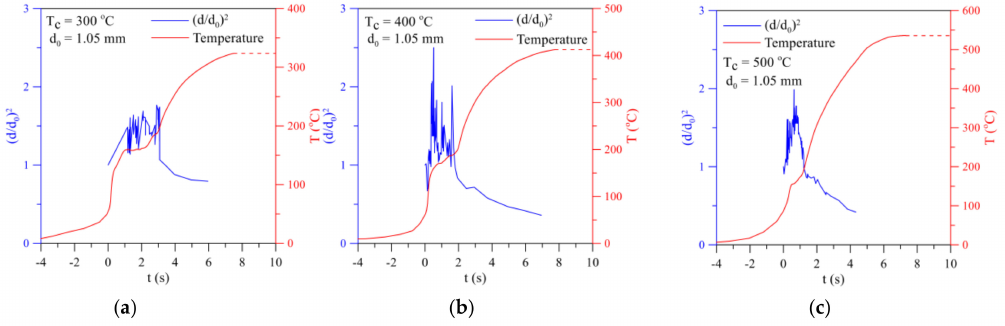
Figure 7. The plots of dimensionless droplet diameter square ( d / d 0 ) 2 versus time and temperature versus time for water-emulsified oil at different ambient temperatures ( a ) 300, ( b ) 400, and ( c ) 500 ◦